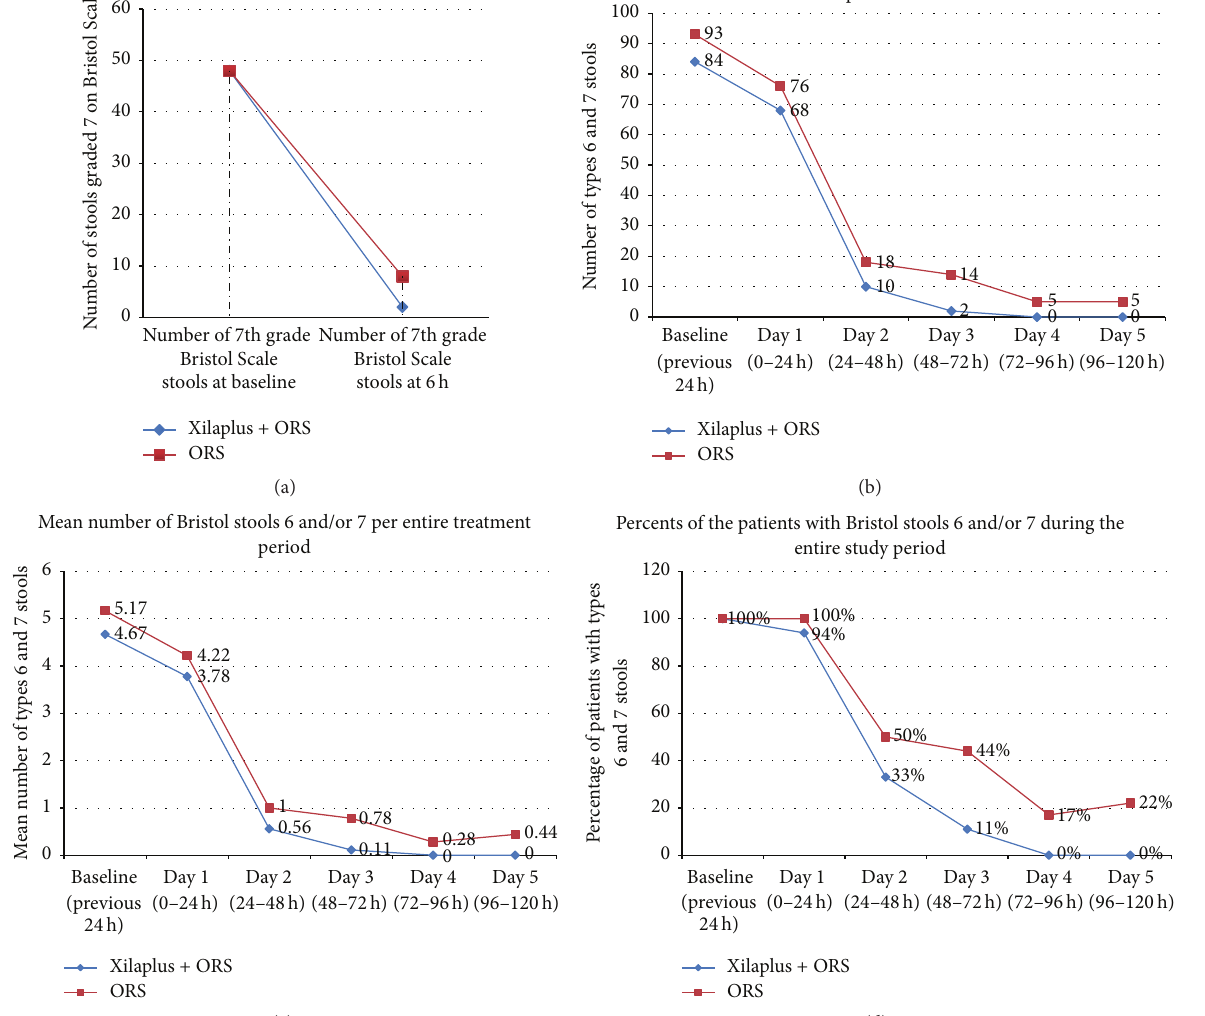
Mean number of Bristol stools 6 and/or 7 per entire treatment Percents of the patients with Bristol stools 6 and/or 7 during the